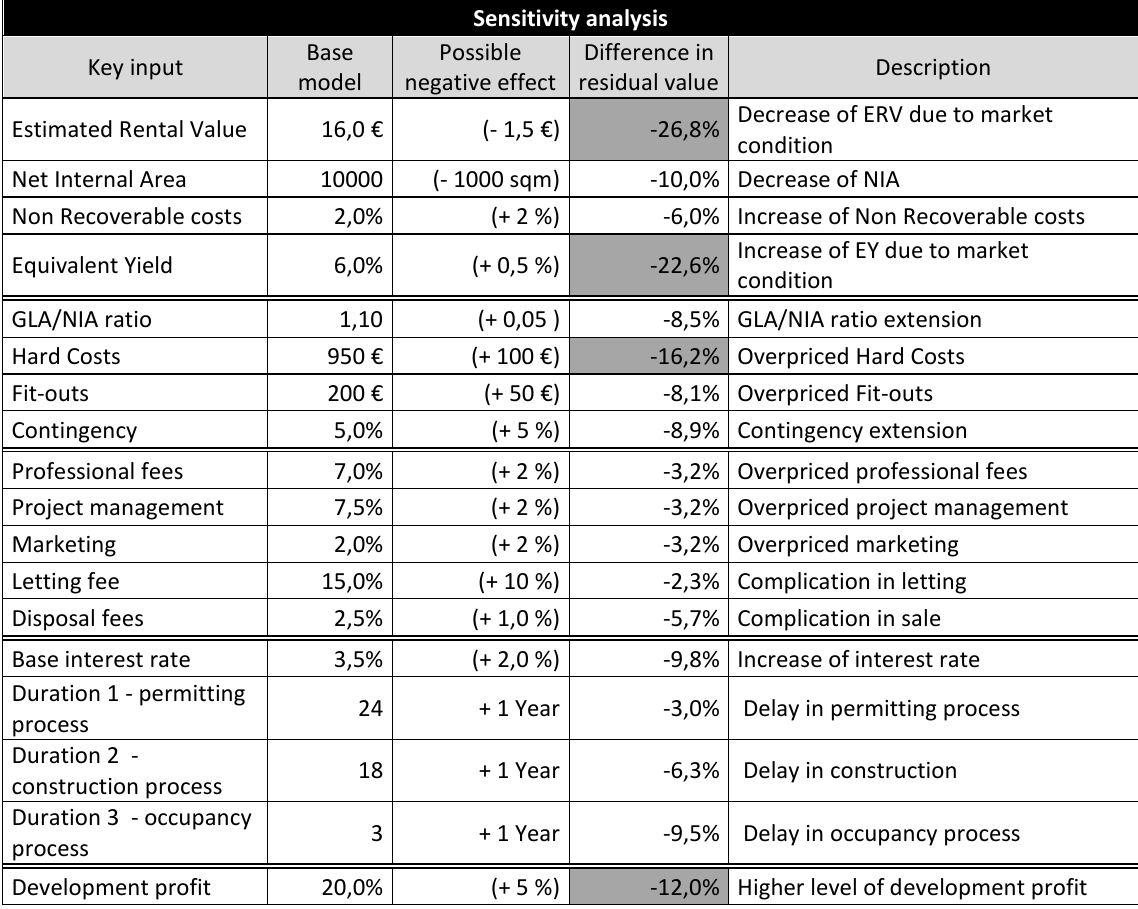
Table 2: Sensitivity of key inputs (source: